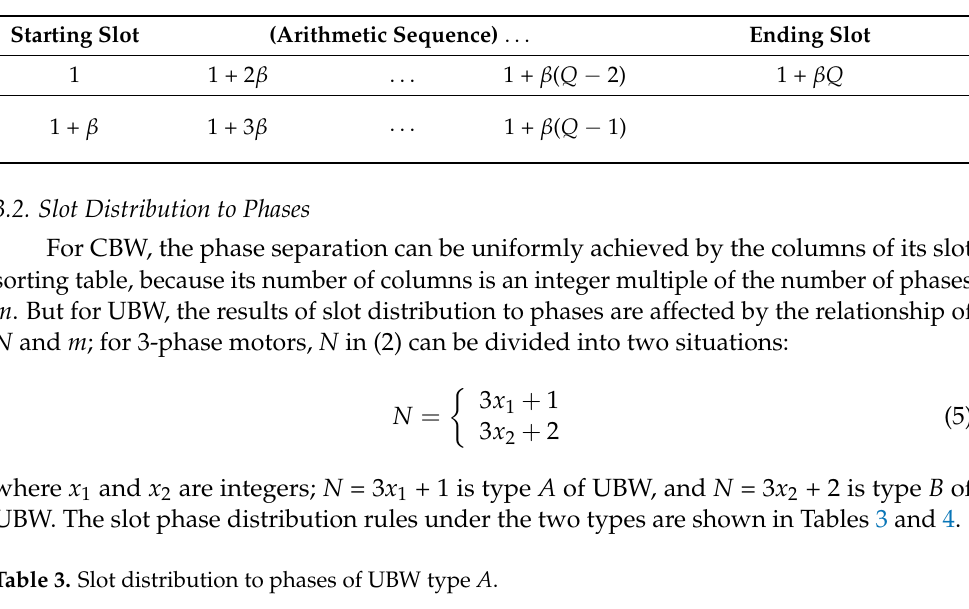
Table 2. Slot sorting of UOSW.